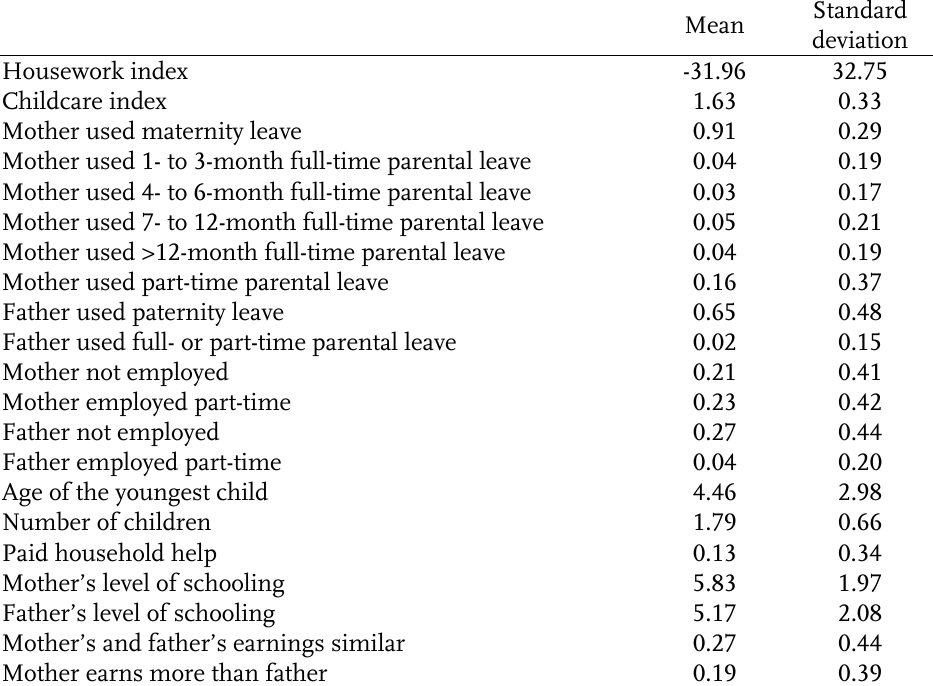
Table 1 : Model variables: means and standard deviations